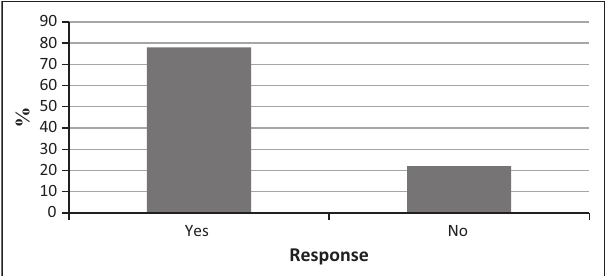
FIGURE 8: Use of the application for planning travel routes and times.